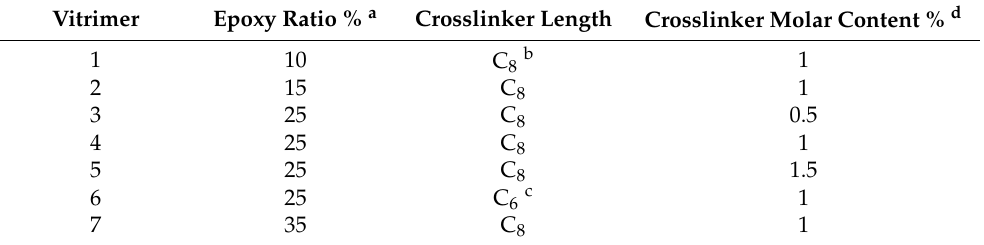
Table 1. The compositions of PB